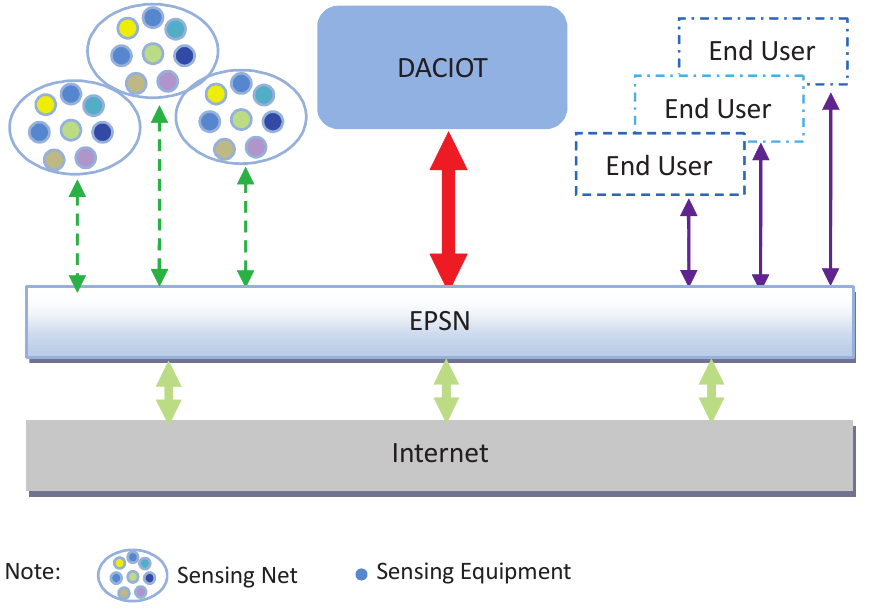
Figure 1. Structure of integration of the IoT application